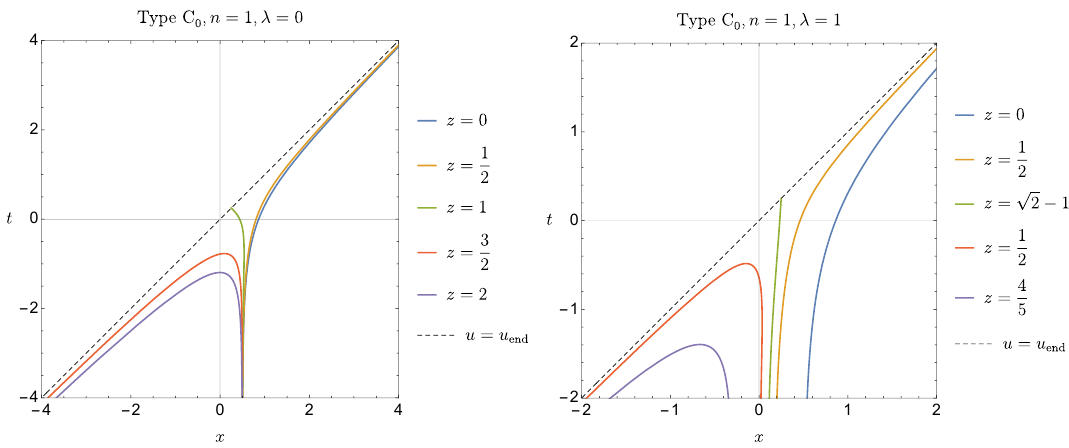
Figure 17 . The profiles of the brane Q associated with mirrors of type C 0 . The mapping functions are defined in eq. (4.5). We have set β = 1 , u